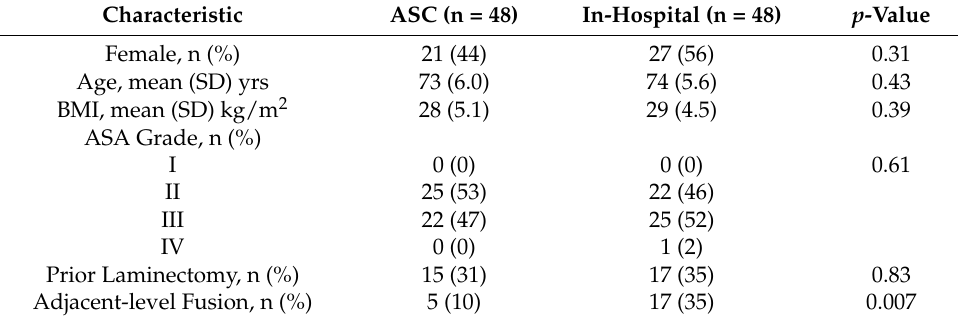
Table 1. Background